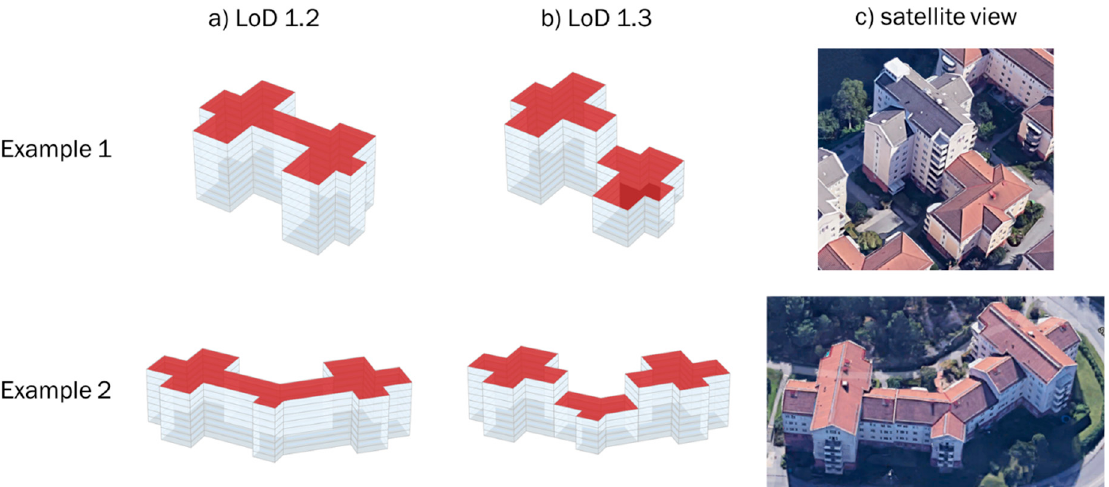
Figure 9. Two sample buildings represented with ( a ) LoD 1.2 and ( b ) LoD 1.3 models in comparison to ( c ) a satellite view.